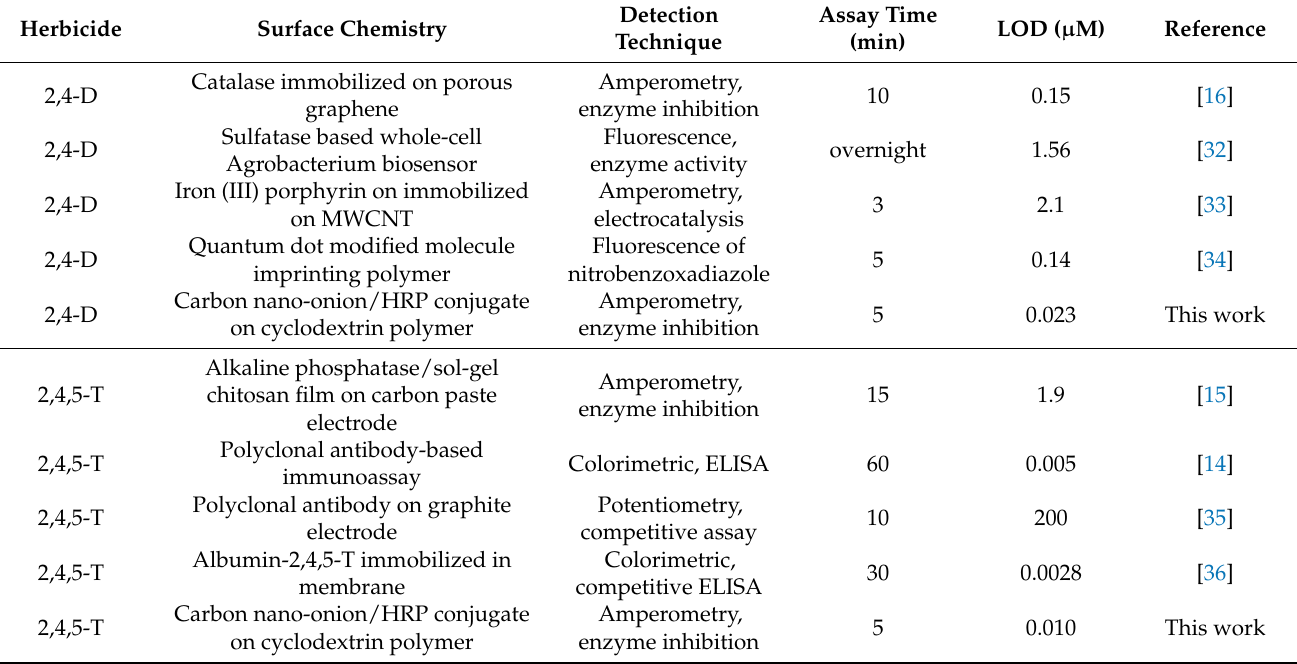
Figure 7. ( a ) Calibration curves of 2,4-D and 2,4,5-T obtained on SPE/CD/CNO/HRP and SPE/CD/HRP biosensors. ( b ) Detail of the curves below 1 µ M concentration and adjusted assuming a linear behavior. Table 2. Comparison of reported detection methods for 2,4-D and 2,4,5-T.